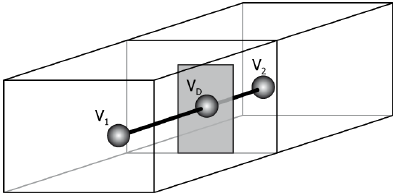
Figure 18. Two adjacent rooms V 1 and V 2 with the “flat” door V D in between.